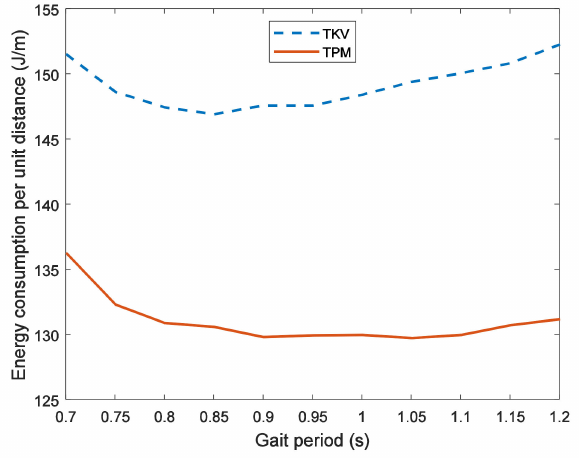
Figure 10. Energy consumption of two gait patterns with different gait periods when L = 0.3 m.